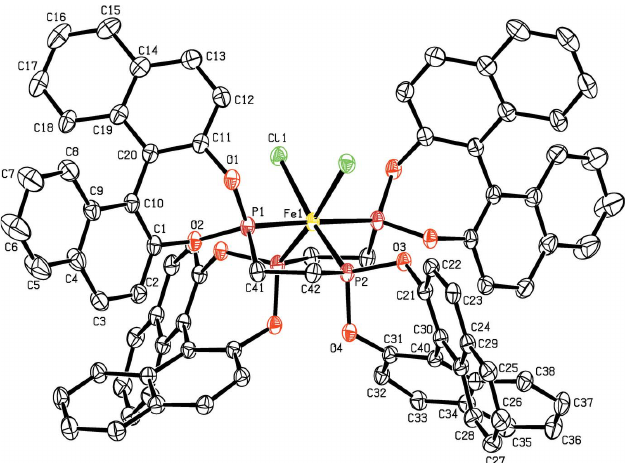
Figure 1 The molecular structure of the title compound with 30% probability ellipsoids. Unlabeled atoms are related by the symmetry operator ( y , x , (cid:4) z + 1) and for the sake of clarity the disordered solvent molecule is not